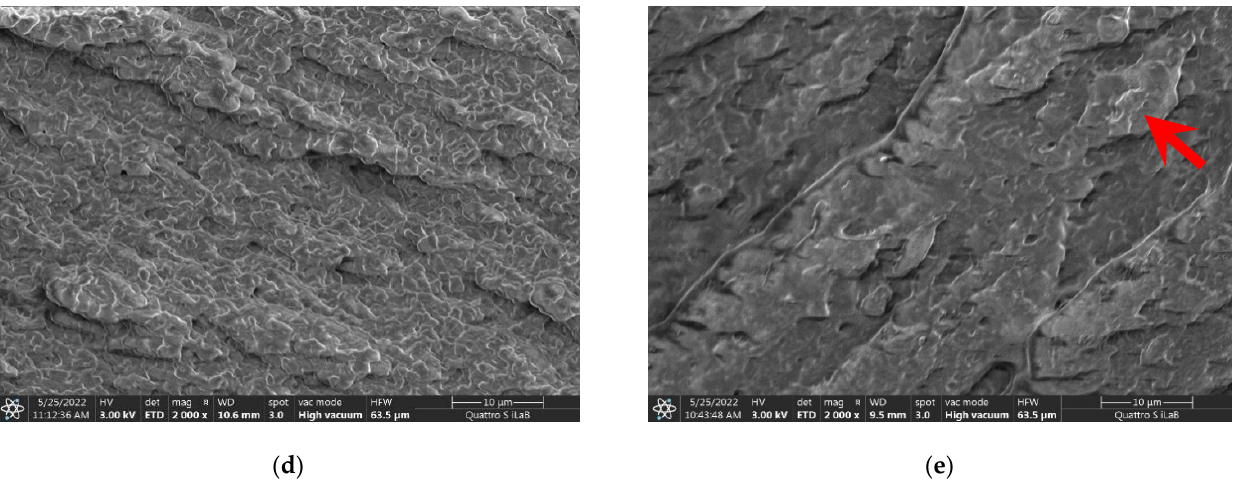
Figure 2. FESEM fracture surface of the PVA film ( a , b ) and the blend films PVA/BA ( c ), PVA/UG ( d ), and PVA/UG/BA ( e ). Tortuous cracks resulting from the disruption of crack progress ( red arrow ).